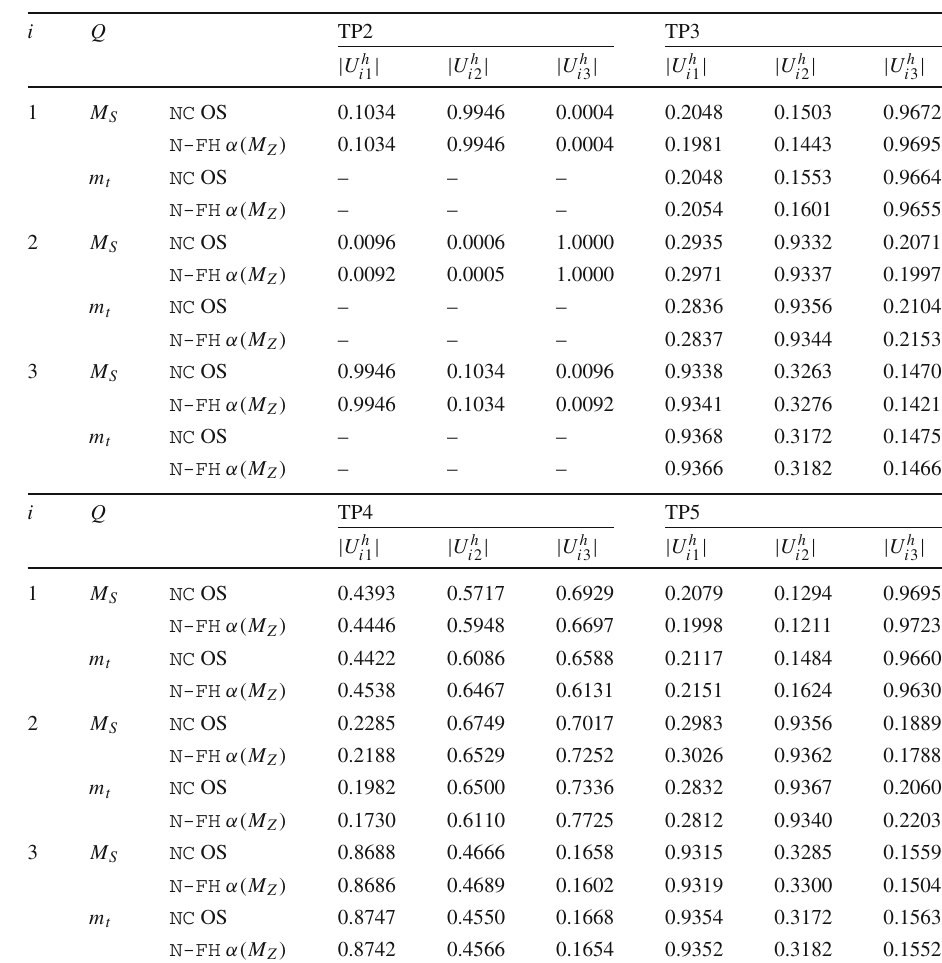
mixing-matrix elements for TP2–TP5 when using the indicated versions of NMSSMCALC and NMSSM-FeynHiggs as specified in the text; see Sect.